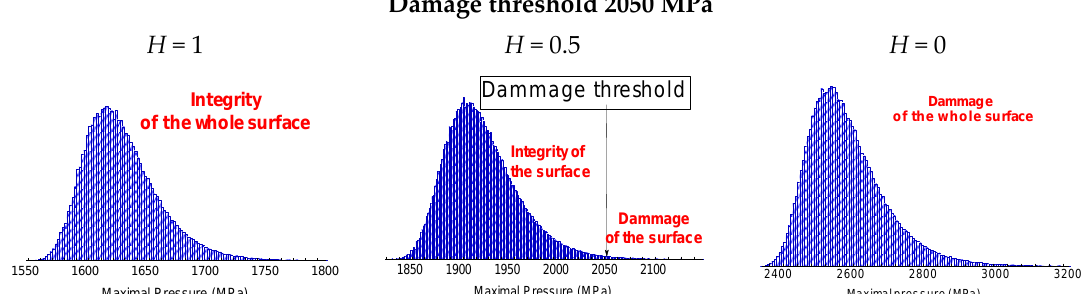
Figure 6. Plots of the GLD probability density functions and empirical histograms parameters for the three local maximal pressures corresponding to the Hurst exponent of H = 0, 0.5 and 1.